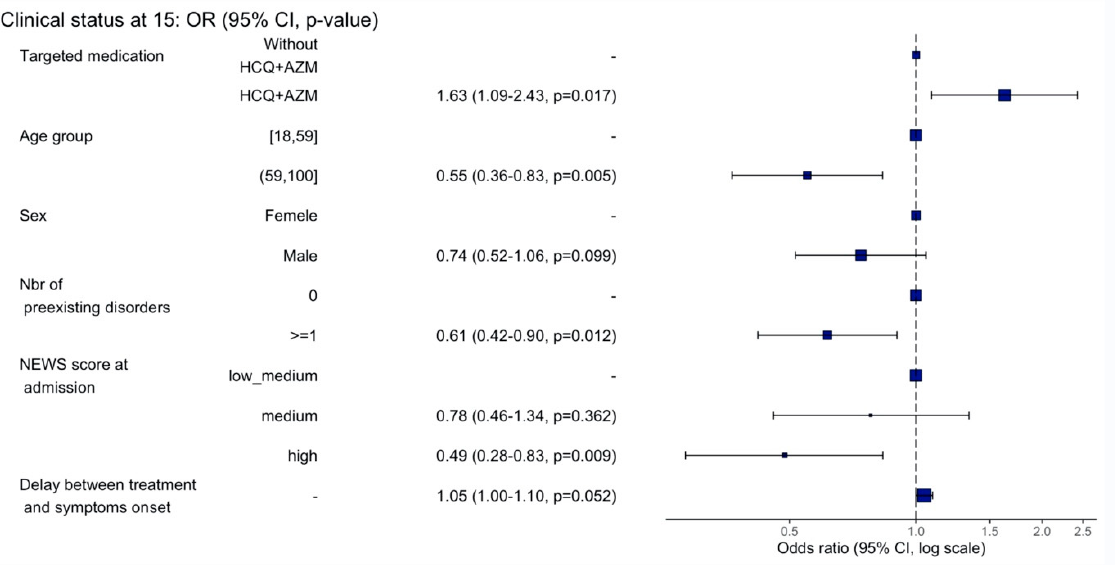
Figure 2. Multivariate analysis of clinical status at D15.